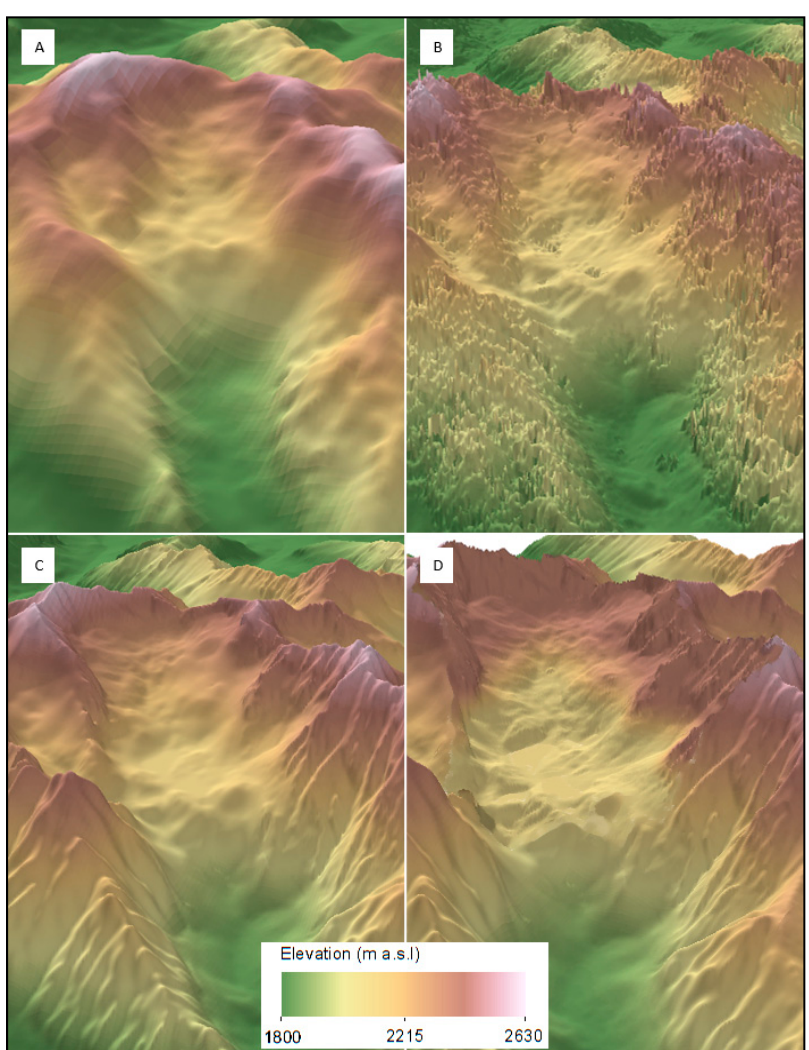
Figure 11. Level of detail of DEMs derived from ( A ) the SRTM data, ( B ) TANDEM-X data, ( C ) topographic contours, and ( D ) fused TLS and UAV-SfM data; all DEMs were resampled to 10 m spatial resolution.